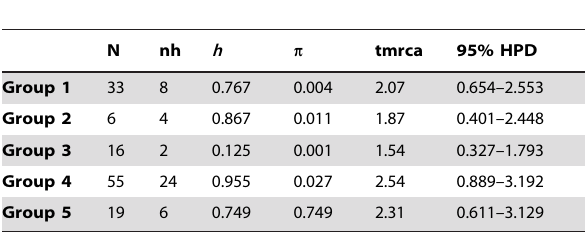
Table 3. Molecular diversity indices for the five southern African groups showing samples size (N), number of haplotypes (nh), haplotype diversity ( h ) and nucleotide diversity ( p ).